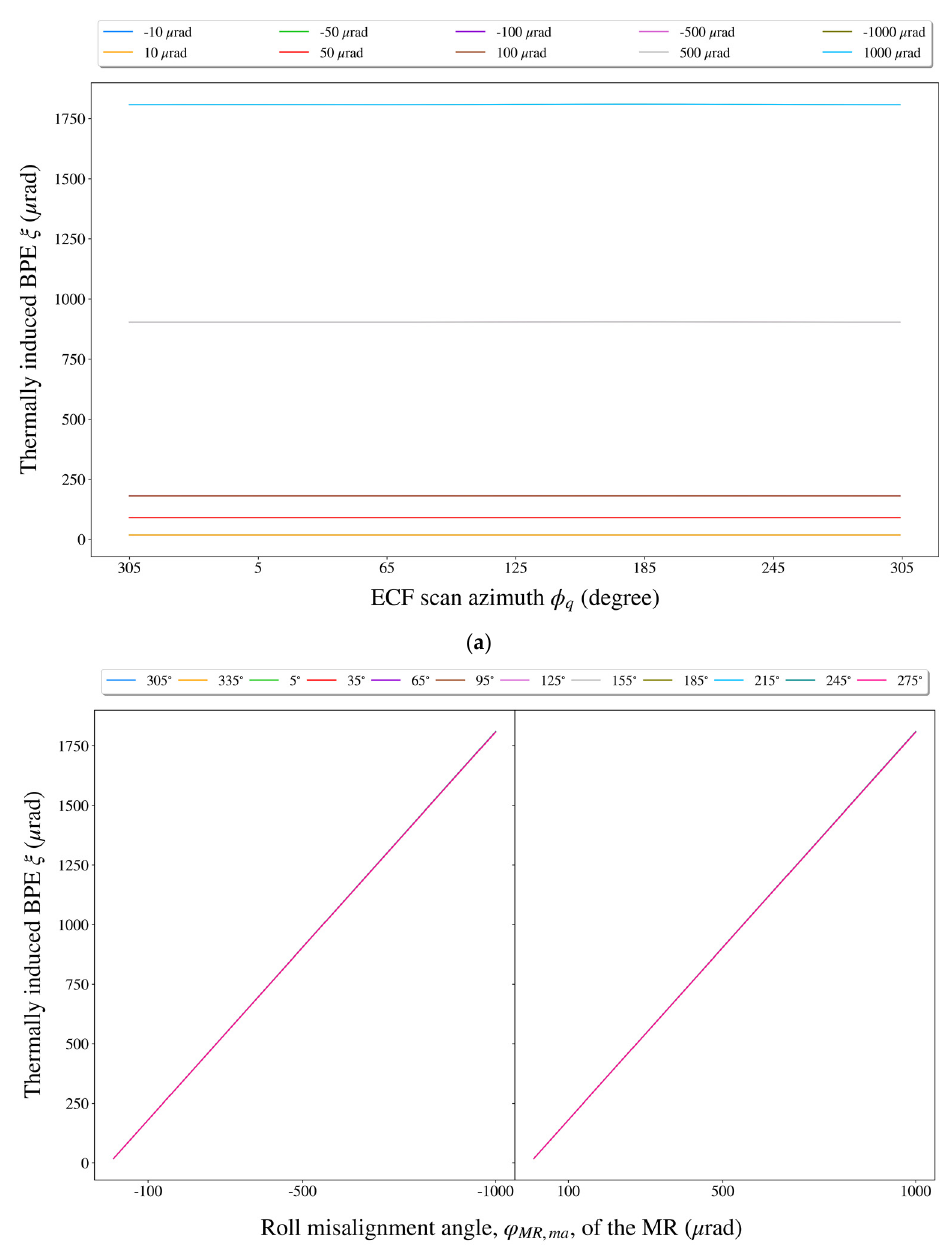
Figure 7. The impact of the roll misalignment angle ϕ MR, ma . of the MR on the BPE. ( a ) The variation of the BPE with respect to the ECF scan azimuth at some fixed levels of ϕ MR, ma . ( b ) The variation of the BPE with respect to ϕ MR, ma at some fixed ECF scan